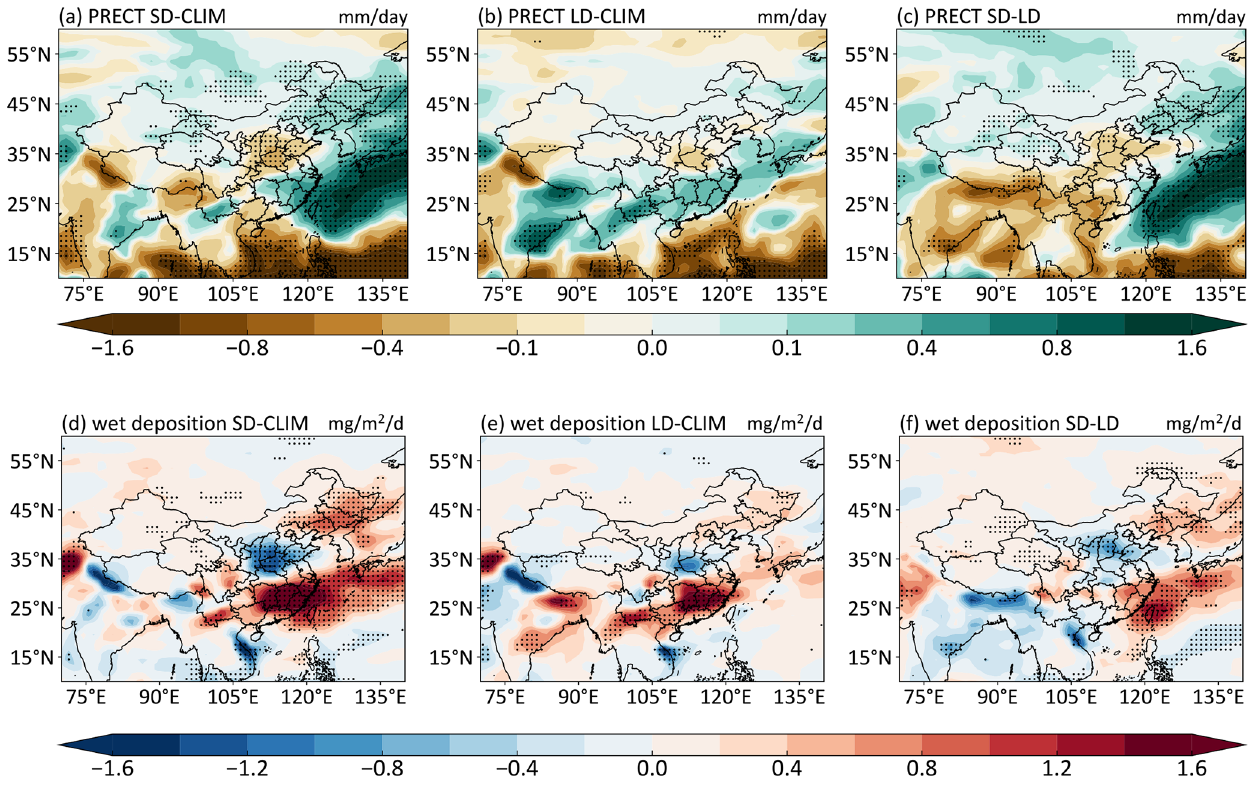
Figure 8. Composite differences in DJF mean precipitation rate ( a–c ; unit: mmd − 1 ) and wet deposition of PM 2 . 5 ( d–f ; unit: mgm − 2 d − 1 ) between SD and CLIM (a, d) , LD and CLIM (b, e) , and SD and LD (c, f) . The stippled areas indicate statistical significance with 90% confidence from a two-tailed t